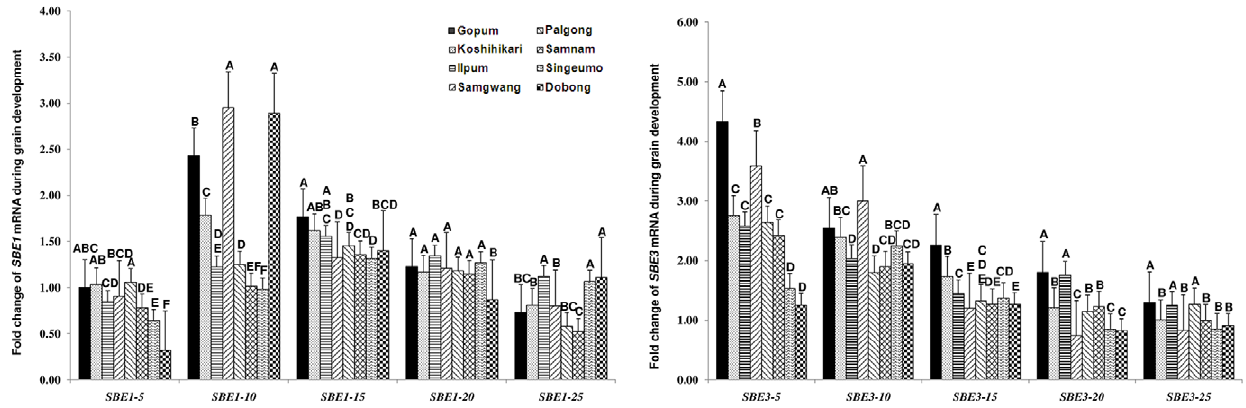
Figure 5. SBE1 and SBE3 expressions based on real-time RT-PCR during grain filling in eight japonica varieties. Letters A–F indicates difference is significant at 0.05 level.